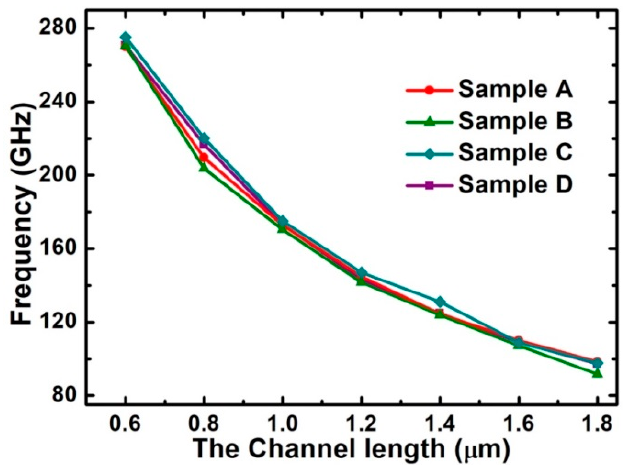
Figure 4. Frequency of the output signal f versus the channel length L.